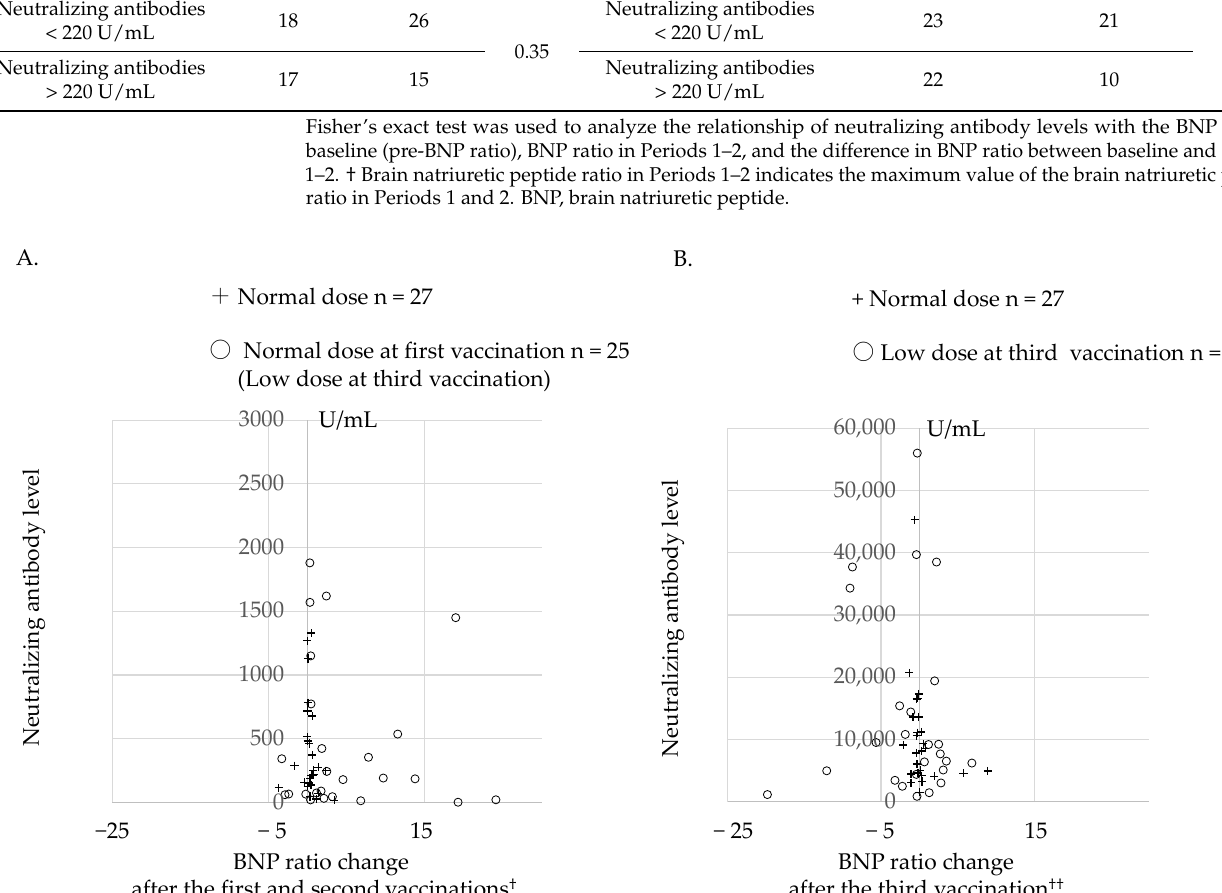
, 25 patients who received (cid:35)